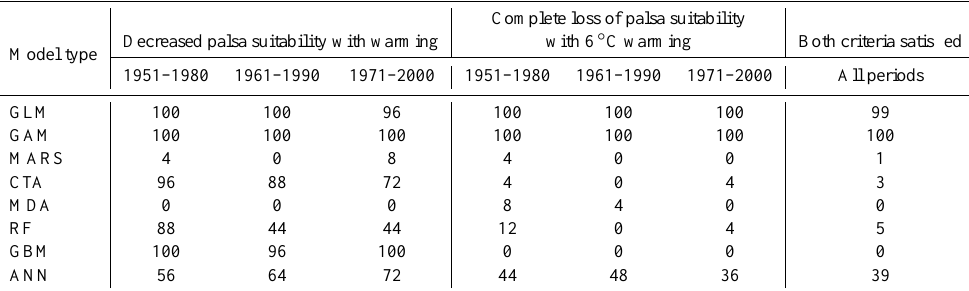
Table 4. Percentage of palsa models simulating decreases in palsa suitability with increased temperature and the total disappearance with 6 ◦ C warming relative to 1961–1990 for three calibration time